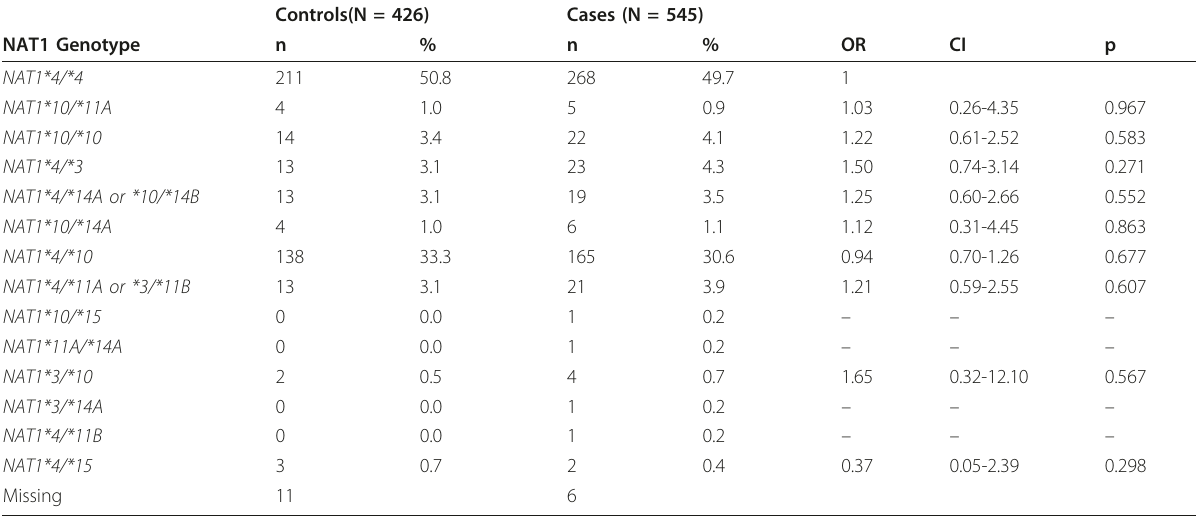
Table 4 Case-control comparison of NAT1 genotypes